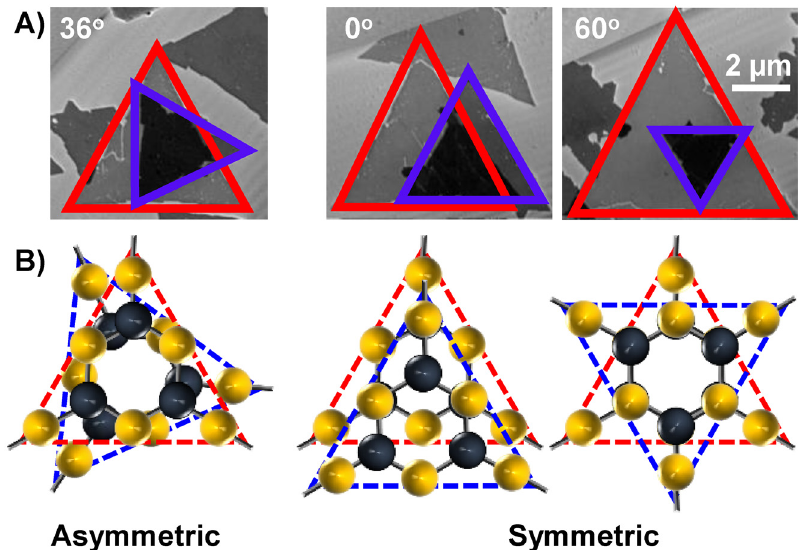
Figure 1: (A) SEM images and (B) Schematic of BL-WSe 2 with asymmetric (36 ° ) and symmetric (0 ° and 60 ° ) stacking angles. Monolayers marked in red and blue triangles are the bottom and the top layers respectively. Black spheres represent W atoms and yellow spheres represent Se atoms. The schematics have been drawn considering the two centrosymmetric